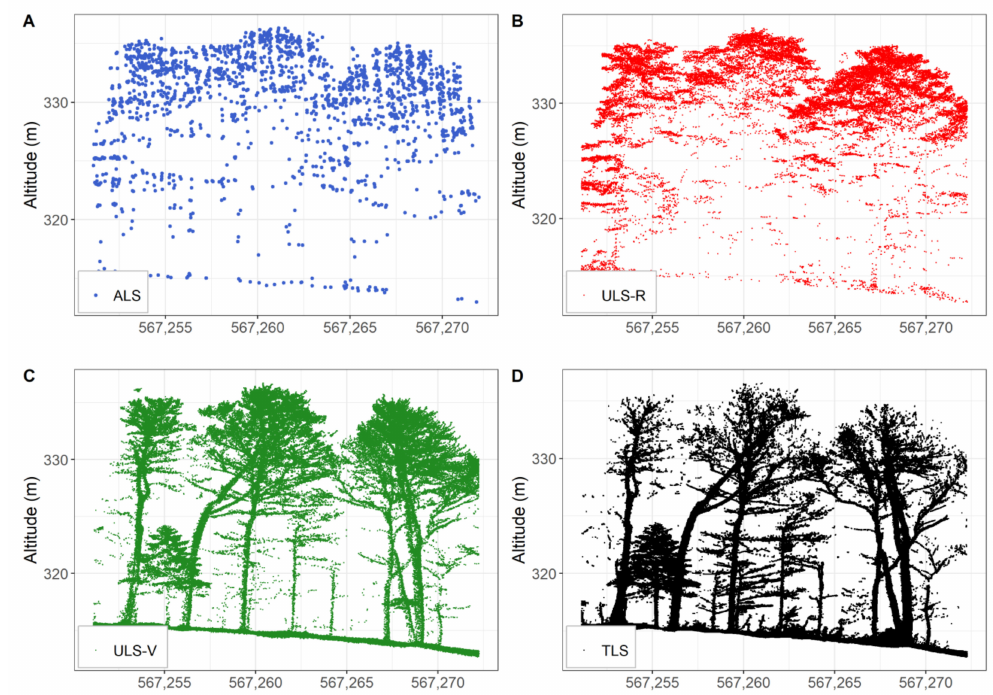
Figure 3. A 20 m-width slice in point clouds to illustrate the relative point density and 3D configuration acquired by each LiDAR system: ( A ) ALS (leaf-on conditions); ( B ) ULS-R (leaf-on conditions); ( C ) ULS-V (leaf-off conditions); and ( D ) TLS (leaf-off